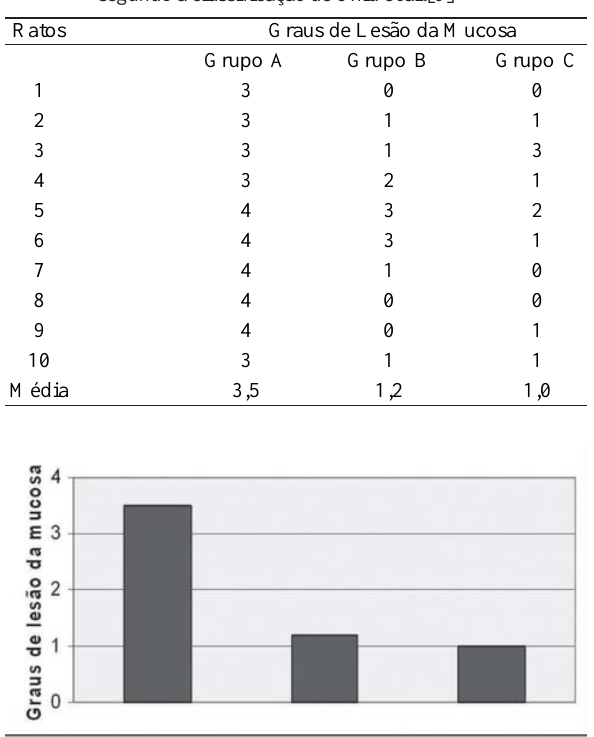
Fig.1 - Gráfico comparativo da análise histológica dos graus de lesão das mucosas intestinais dos ratos dos grupos A, B e C segundo a classificação de Chiu et al. [6] No grupo B, a média do grau de lesão tecidual foi 1,2. Neste grupo, três animais não apresentaram lesão (grau 0), quatro tiveram lesão grau 1, um, grau 2, e dois, grau 3. No grupo C, a média do grau de lesão tecidual foi